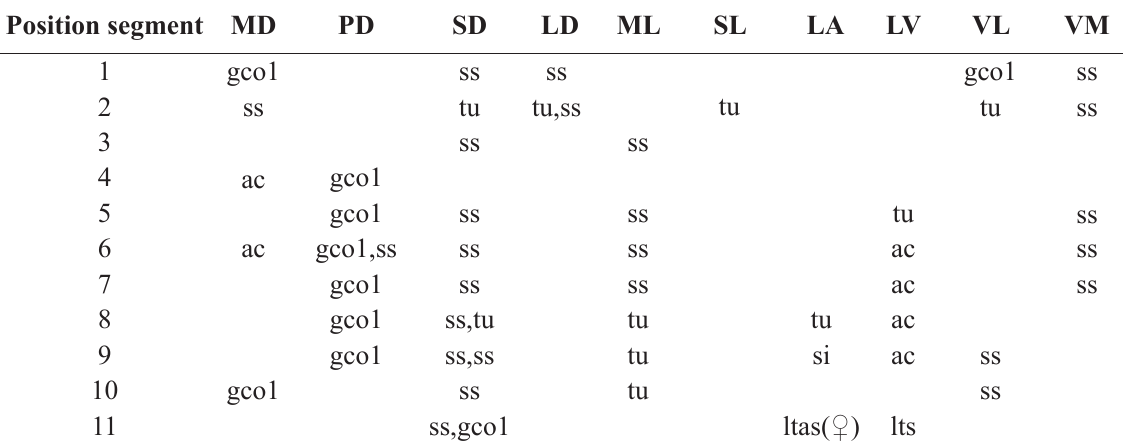
Table 5. Summary of nature and location of sensory spots, glandular cell outlets, tubes and spines arranged by series in Echinoderes landersi sp.